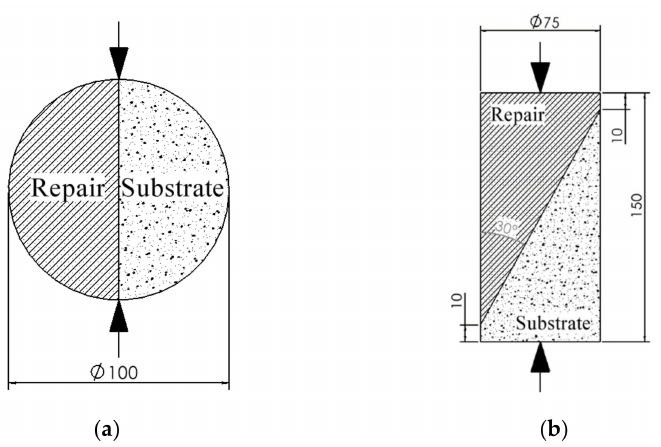
Figure 4. Bond test sketches ( a ) Splitting tensile test ( b ) Slant shear test (all dimensions in